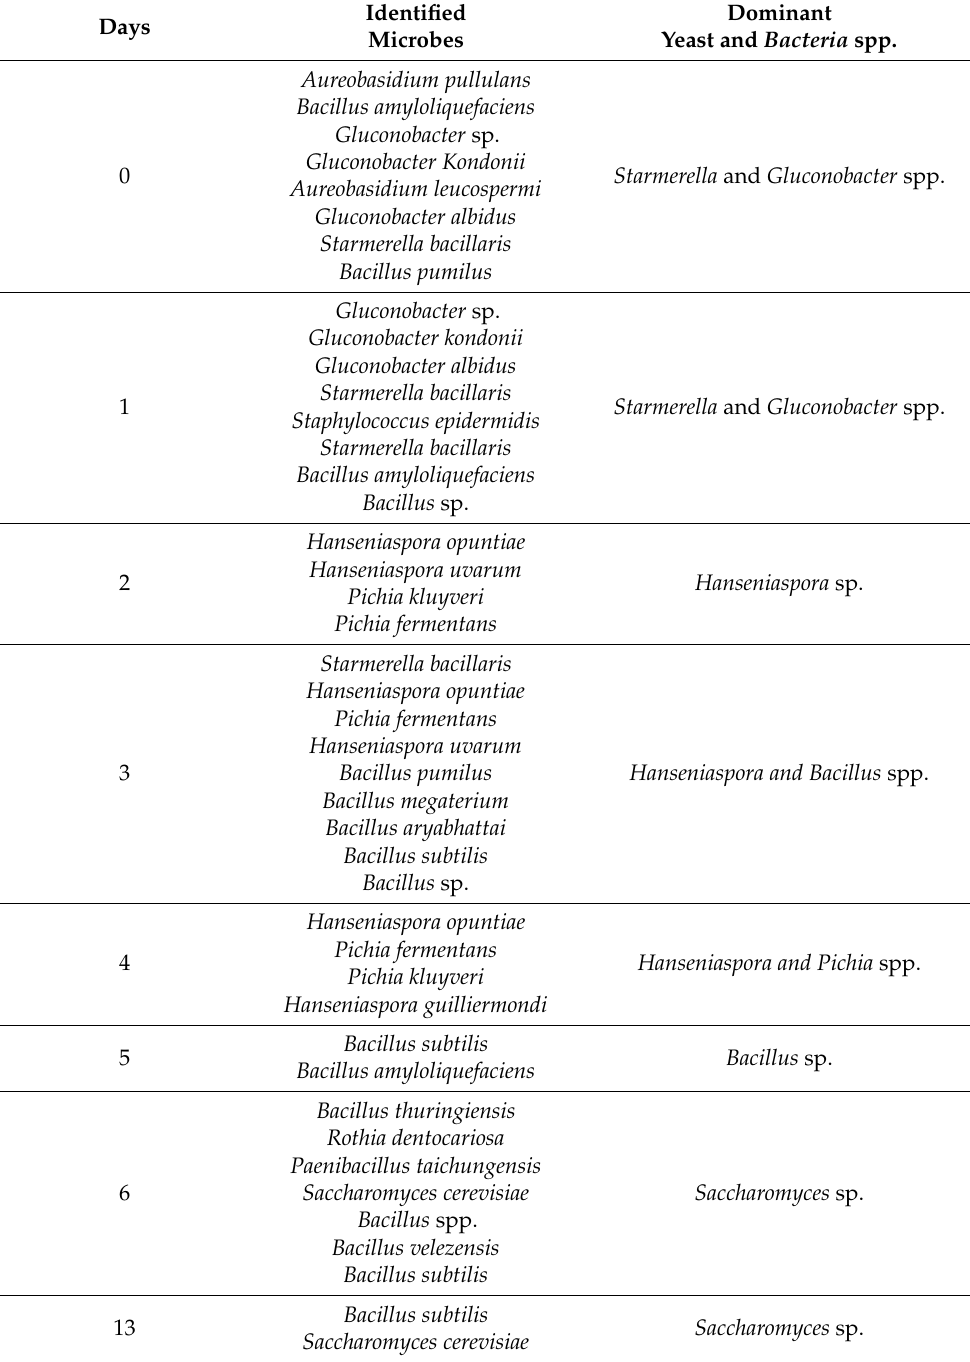
Table 1. Bacteria and yeast species isolated during spontaneous fermentation of cactus pear wine. Days